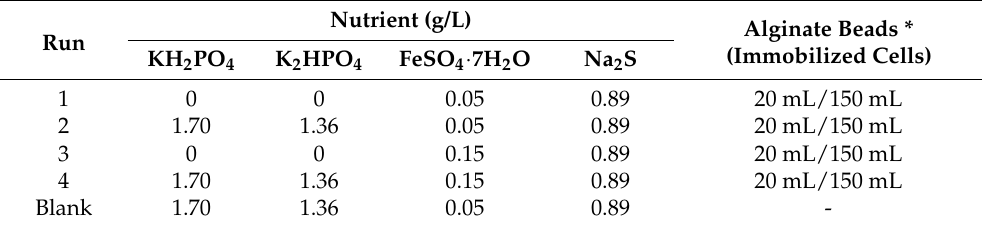
Table 2. Variations of nutrient